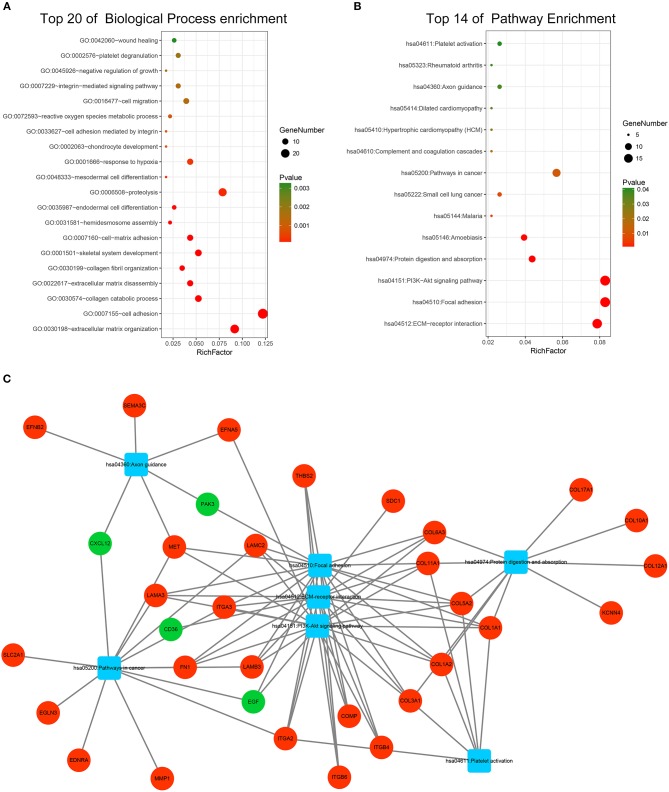
Functional enrichment analysis of the DEGs. (A) Top 20 enriched biological processes of the DEGs. (B) Top 14 enriched KEGG pathways of the DEGs. (C) Visualization of enriched cancer related pathways and their corresponding DEGs. Up-regulated DEGs are represented in red while down-regulated DEGs are represented in green. Pathways are represented in blue.